Question: What visual encoding does this figure use to show its data?
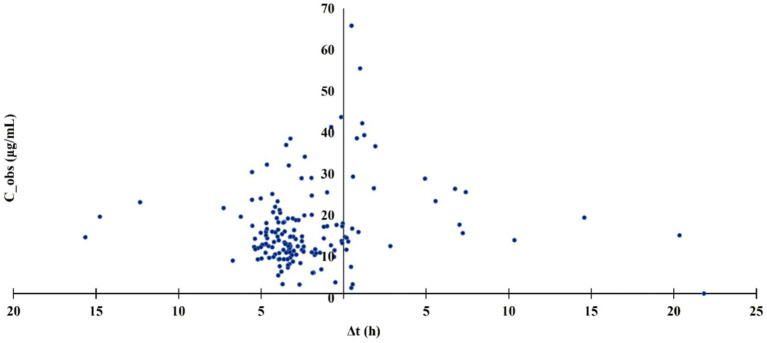
Answer: scatter